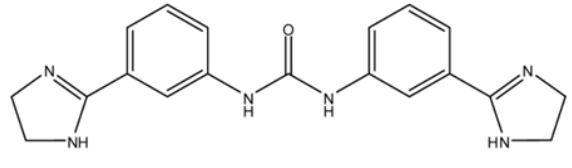
Figure 1. Molecular structure of